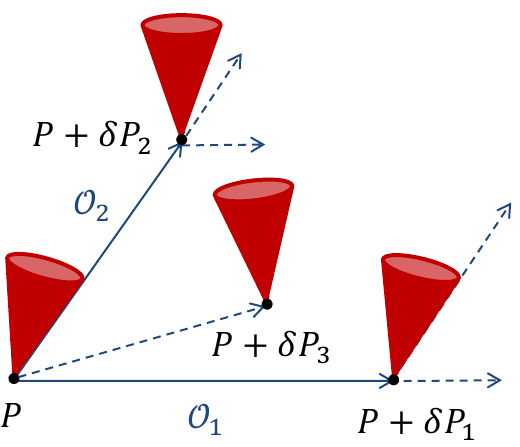
Figure 1 . A depiction of the main argument. We start at a point P of M c with a set of exactly marginal deformations, O 1 and O 2 . The moduli space, depicted as a red cone, at P might have a common direction with M c , say O 2 . However, once we move along O 2 to P + (cid:14)P 2 the moduli space cannot have a component along the O 2 direction. Moreover, on a generic locus P + (cid:14)P 3 of M c the moduli space and M c have no common directions. On complex co-dimension one (or higher) loci P + (cid:14)P 1 some marginal operators, say O 1 in the (cid:12)gure, might have common